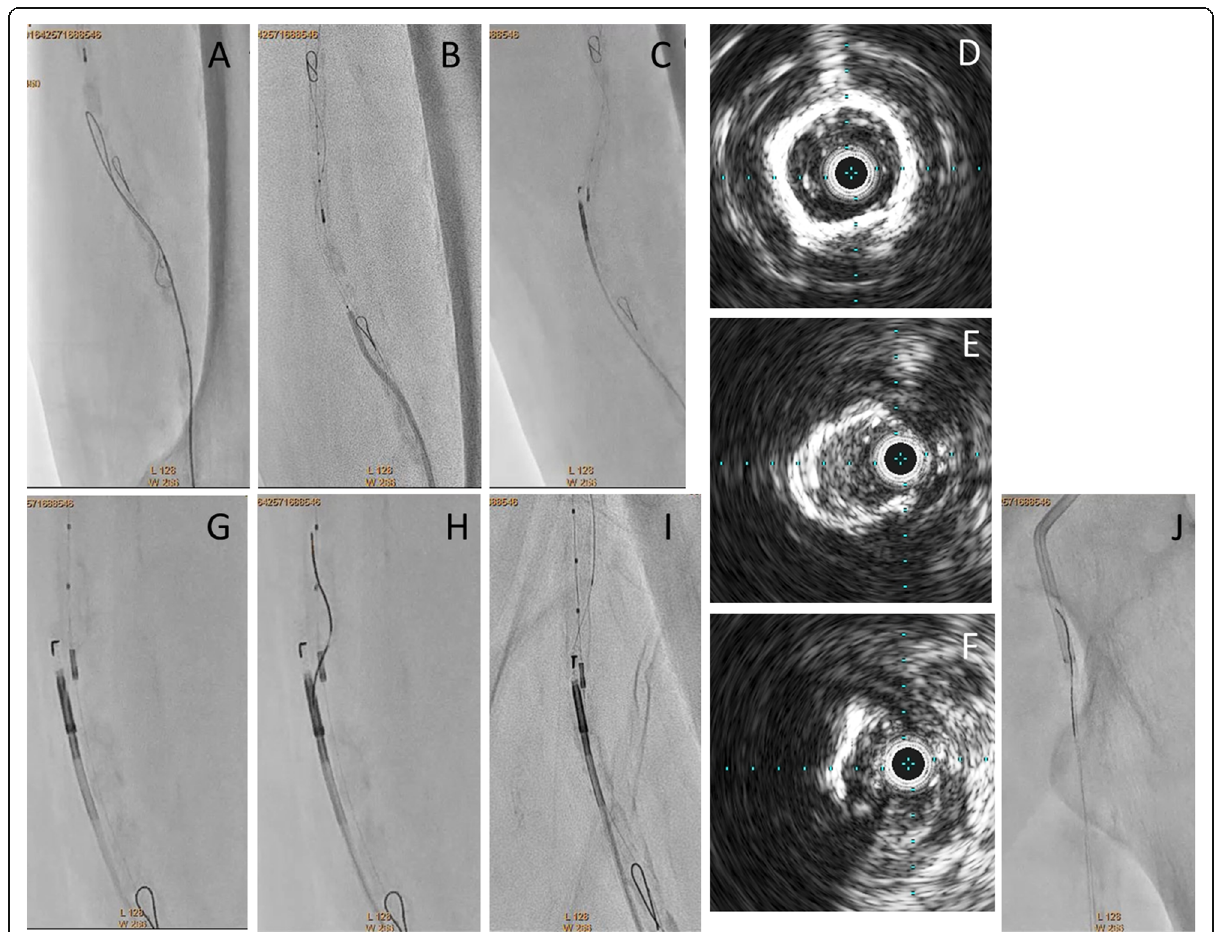
Fig. 3 a : Advancement of knuckle-shaped 0.035-in. Radifocus wire. b : Both wires are closed. Antegrade intravascular ultrasound showing that the antegrade wire is in the intraplaque space and the retrograde wire is in the subintimal space. The retrograde route is dilated with a 3.0-mm balloon to enable the advancement of the Outback® Elite catheter (Cordis, Florida, USA). c : The Outback® Elite catheter is advanced retrogradely under intravascular ultrasound guidance from the antegrade direction. d : The IVUS findings of proximal SFA showed 360 degree heavy calcification. e : The IVUS findings showed 180 to 270 degree calcification. f : The IVUS findings from retrograde showed the retrograde IVUS catheter was in the subintimal space, and true lumen was relatively few calcified parts. This was the place where we tried out re-entry from retrograde using Outback® Elite catheter. g : Use of the Outback® Elite catheter. Adjustment of the L marker. h : Adjustment of the T marker. i : Successful re-entry. j : Advancement of the retrograde wire into